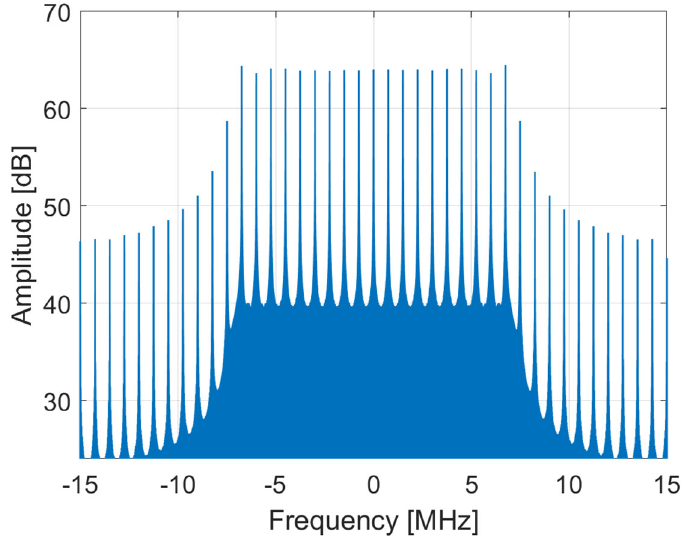
Figure 12. Spectrogram of the joint waveform based on FBMC chirp.